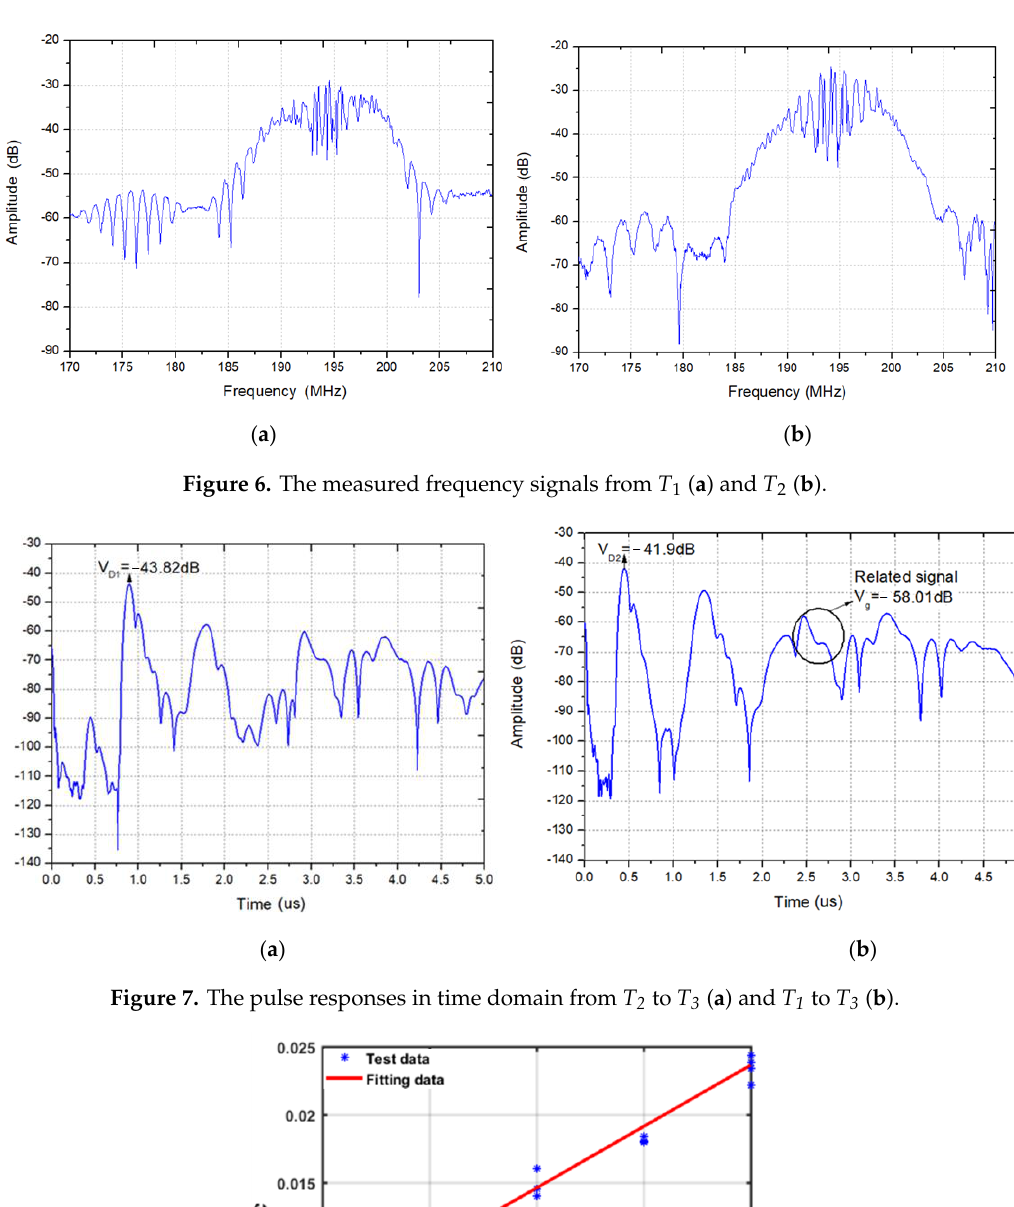
Figure 7. The pulse responses in time domain from T 2 to T 3 ( a ) and T 1 to T 3 ( b ).